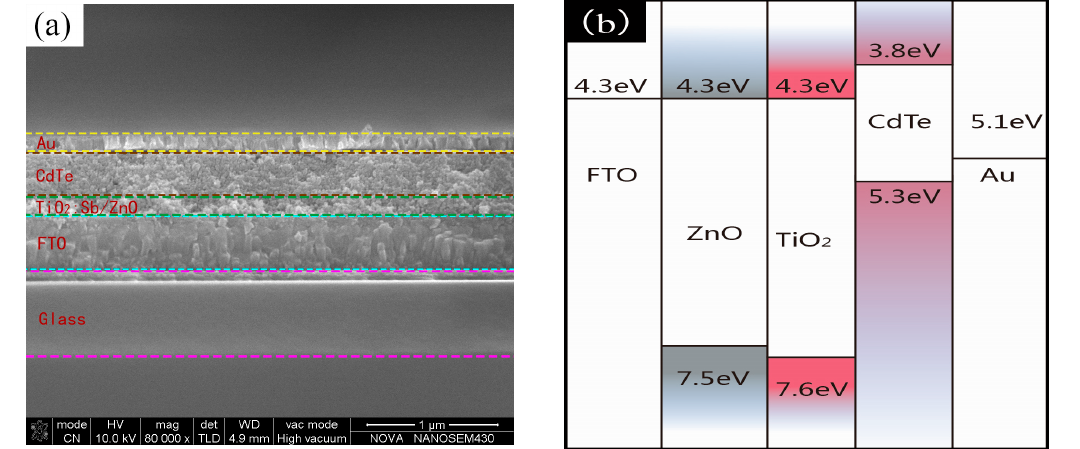
Figure 2. ( a ) Cross-sectional SEM images of the FTO/ZnO/TiO 2 /CdTe/Au device architecture; ( b ) band alignment of FTO, ZnO, TiO 2 , CdTe, and Au.